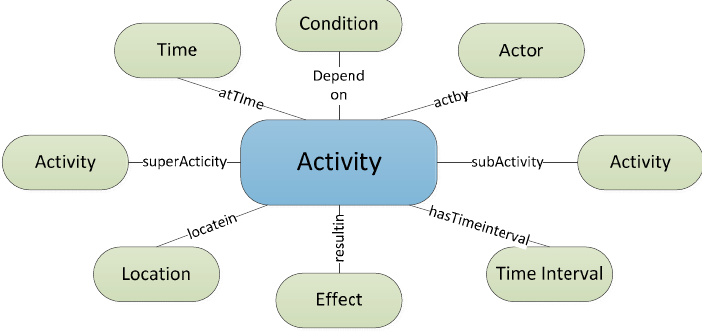
Figure 5. The concept model of activity.